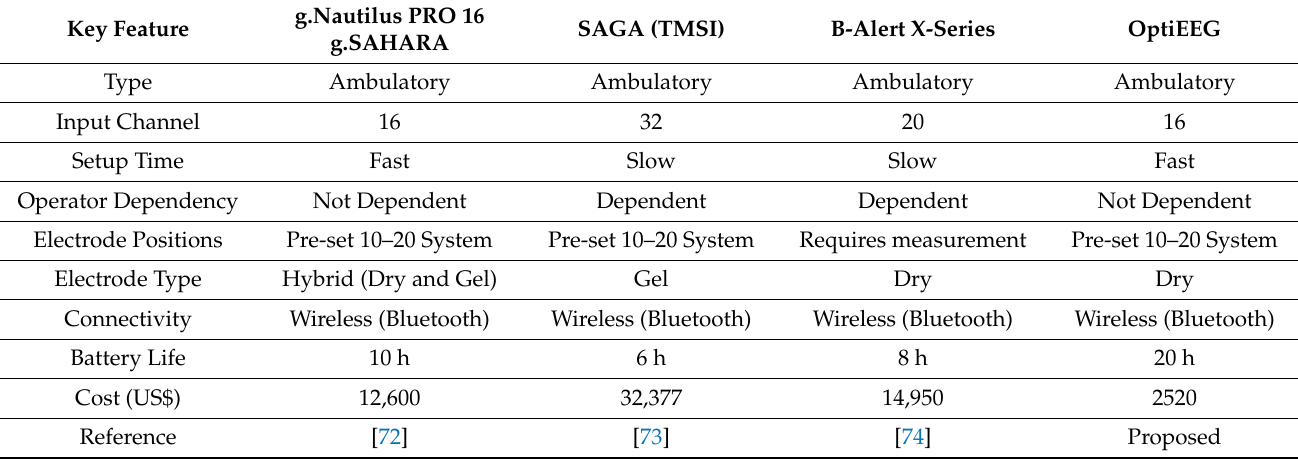
Table 4. Comparison of ambulatory